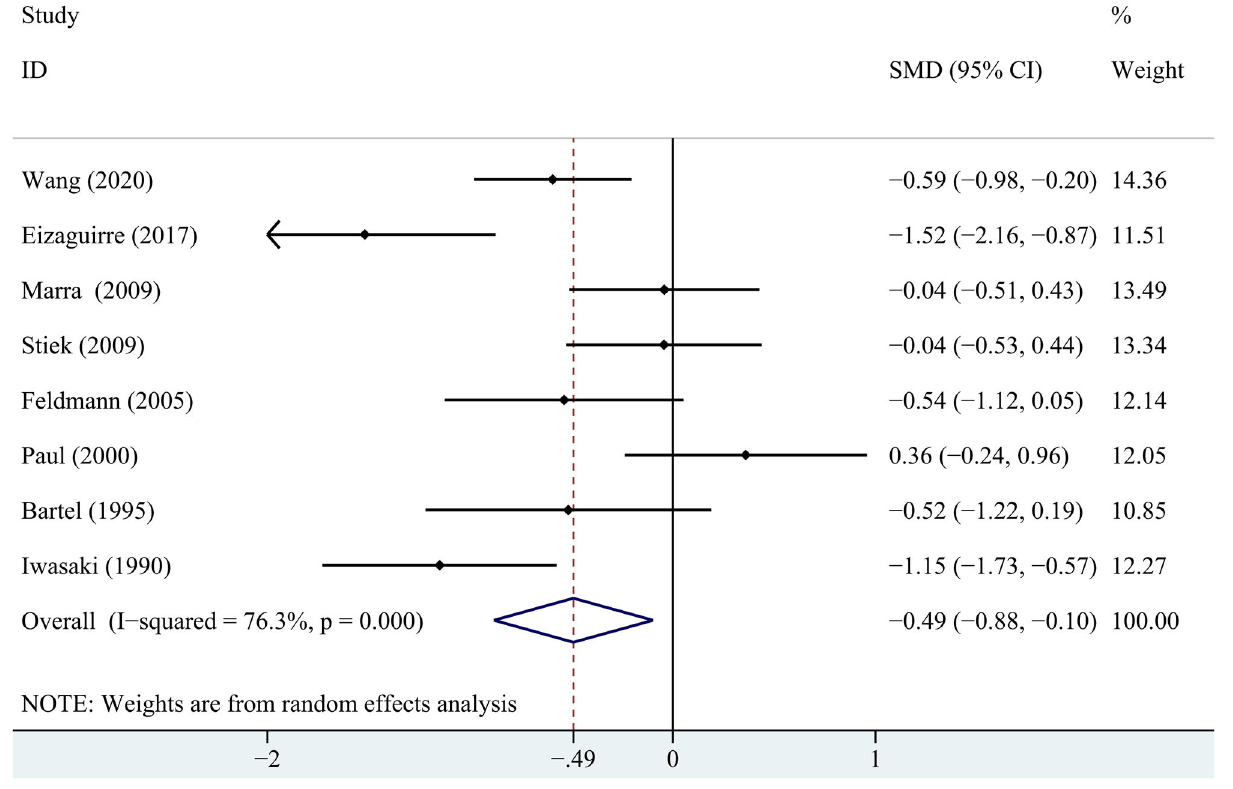
FIGURE 3 | A forest plot of the association between MG and delayed recall memory.